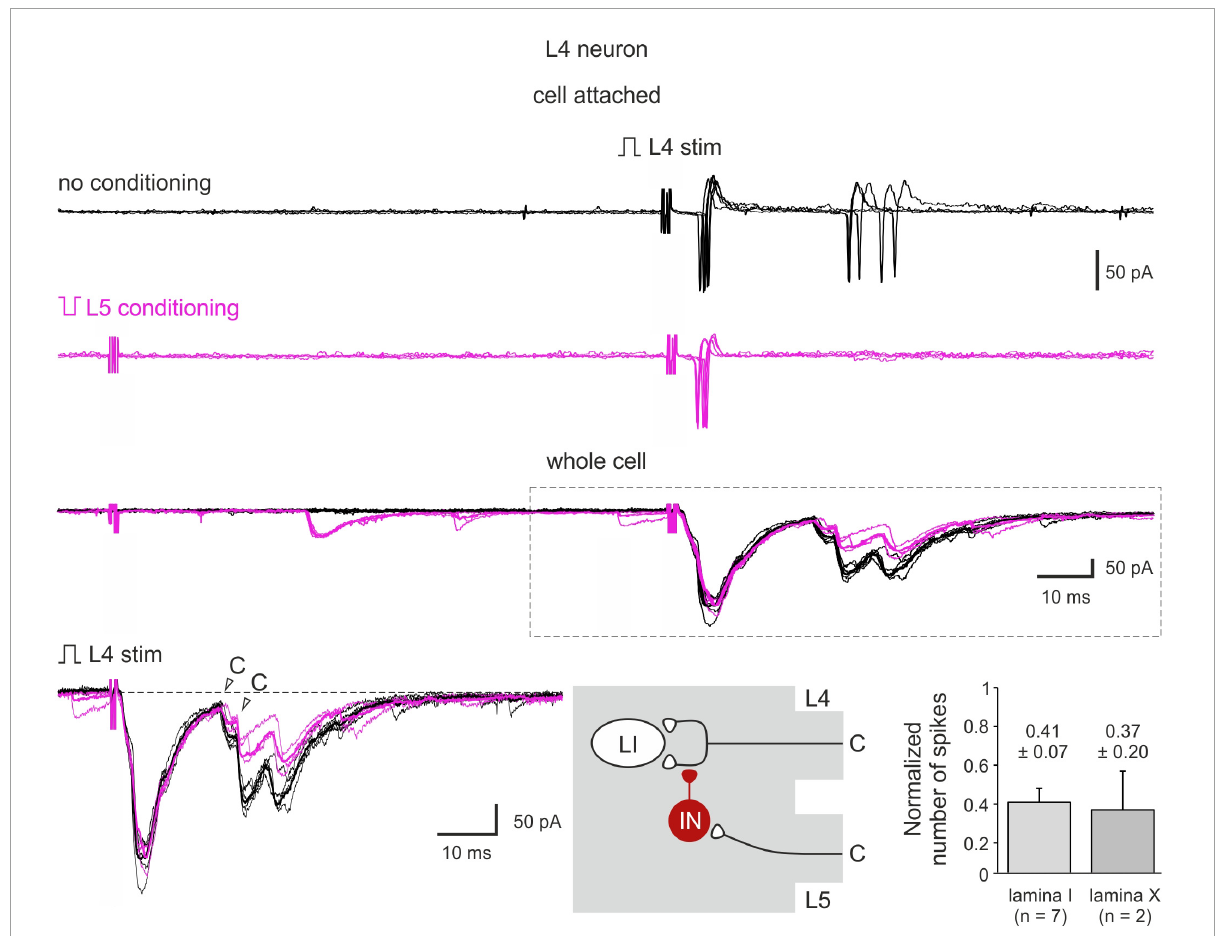
FIGURE6 C-AD-PI controls spike discharges in spinal neurons. Cell-attached recording of action potential (AP) firing and the whole-cell recordings of the excitatory postsynaptic currents (EPSCs) evoked by the L4 dorsal root stimulation in a lamina I neuron in control (black) and after the L5 C-fiber conditioning (magenta). Individual (five traces) and averaged (bold) traces of the EPSCs are shown. Bottom middle: schematics showing PI induction. IN, inhibitory interneuron; LI, lamina I neuron. Traces in the inset are shown below at higher magnification. Bottom right: decrease in the number of spikes in lamina I and lamina X